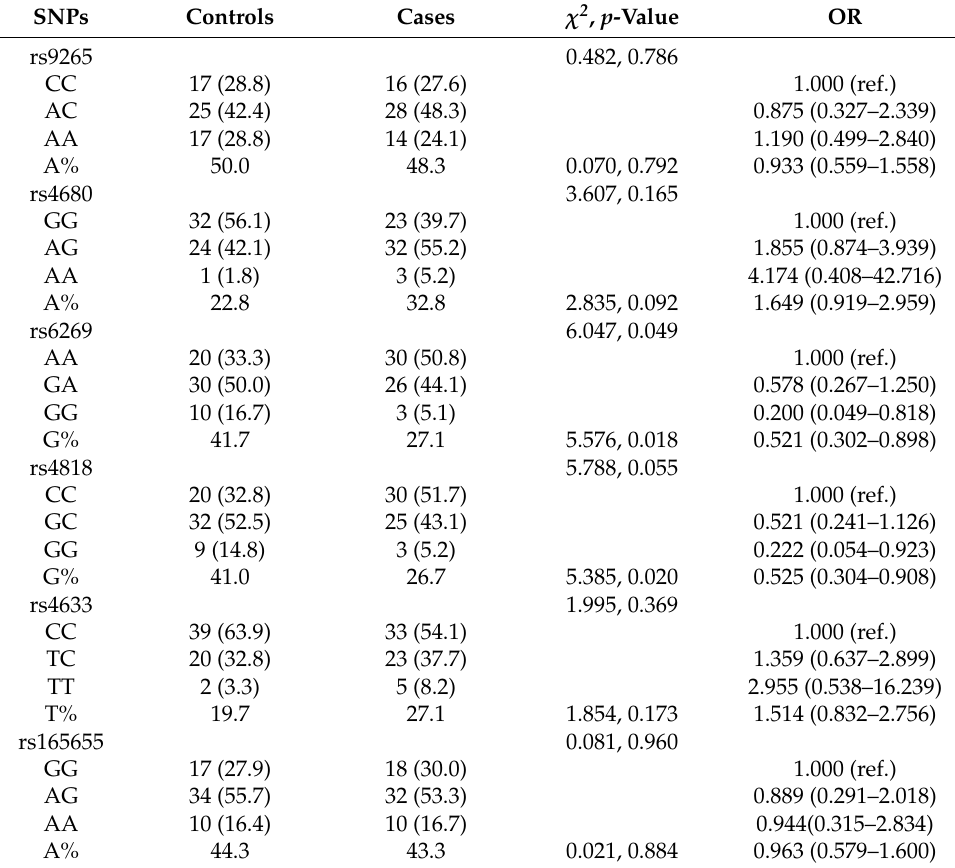
Table 3. Allele and genotype distributions of the SNPs in the COMT gene in the PARIs cases and the non-PARI